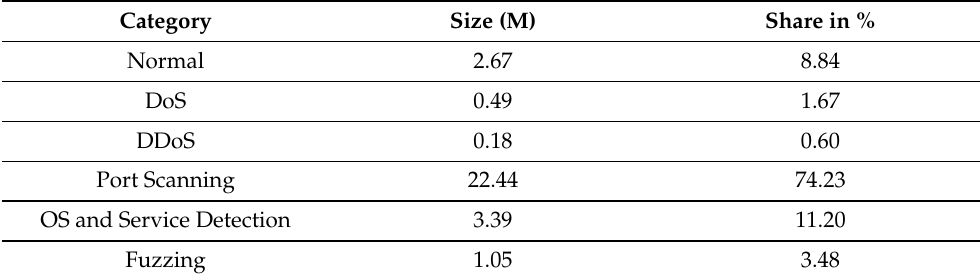
Table 1. Datasets category and its distribution in size and